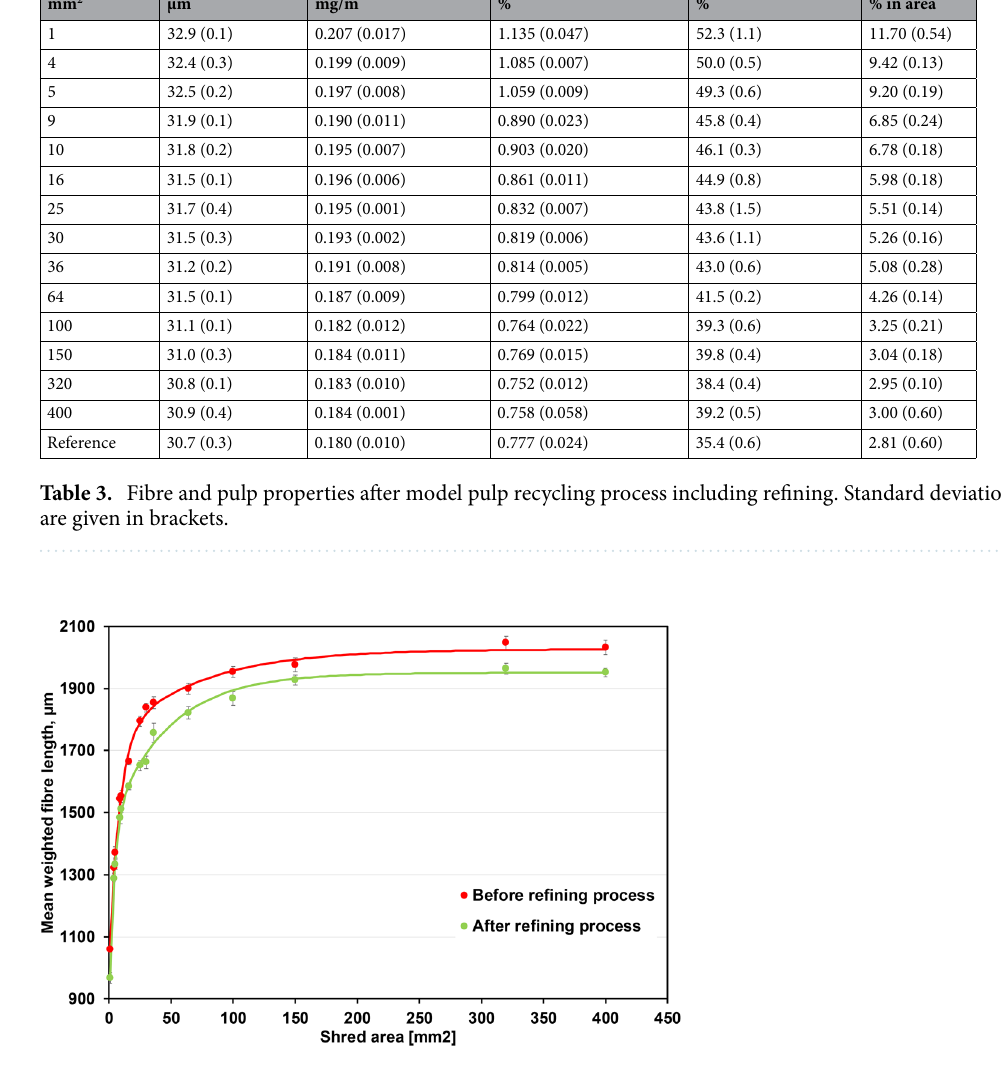
Figure 1. Average fibre length dependency on the cut surface area of samples (before and after model pulp recycling process including